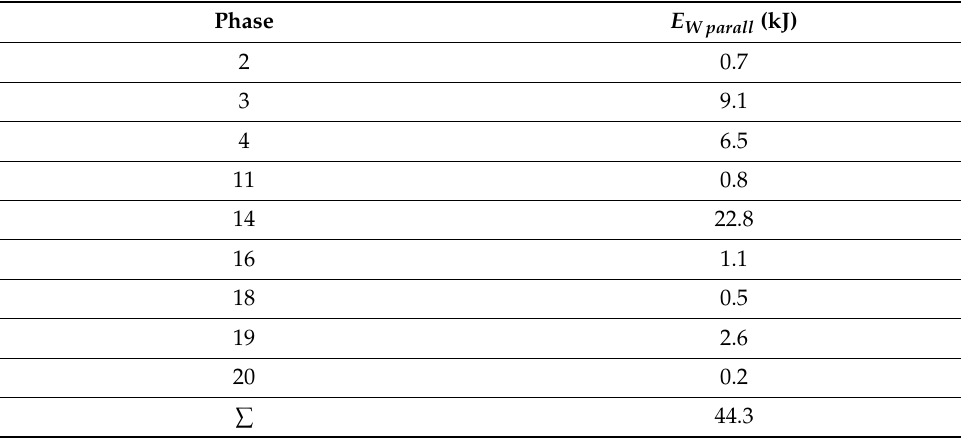
Table 5. Energy dissipated in the less loaded actuators (phases with parallel